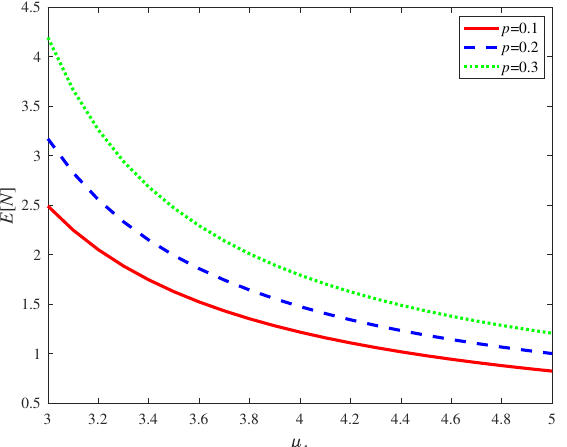
Figure 4. Relation between E [ N ] and µ 1 .